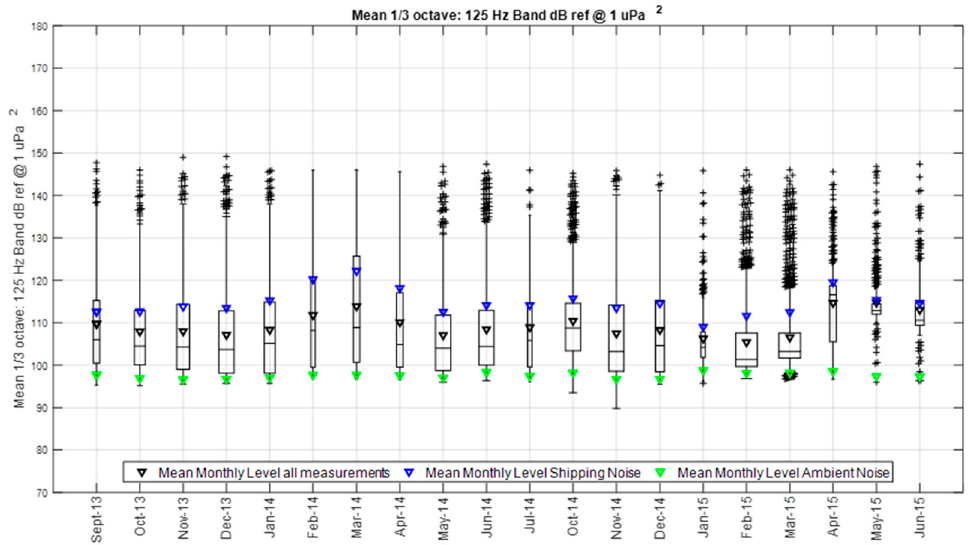
Figure 9. Monthly average evolution of the maximum of the 1/3 octave band at 125 Hz. The mean monthly values of shipping, other anthropogenic, and natural noise measurements are represented with blue, black, and green triangles, respectively.